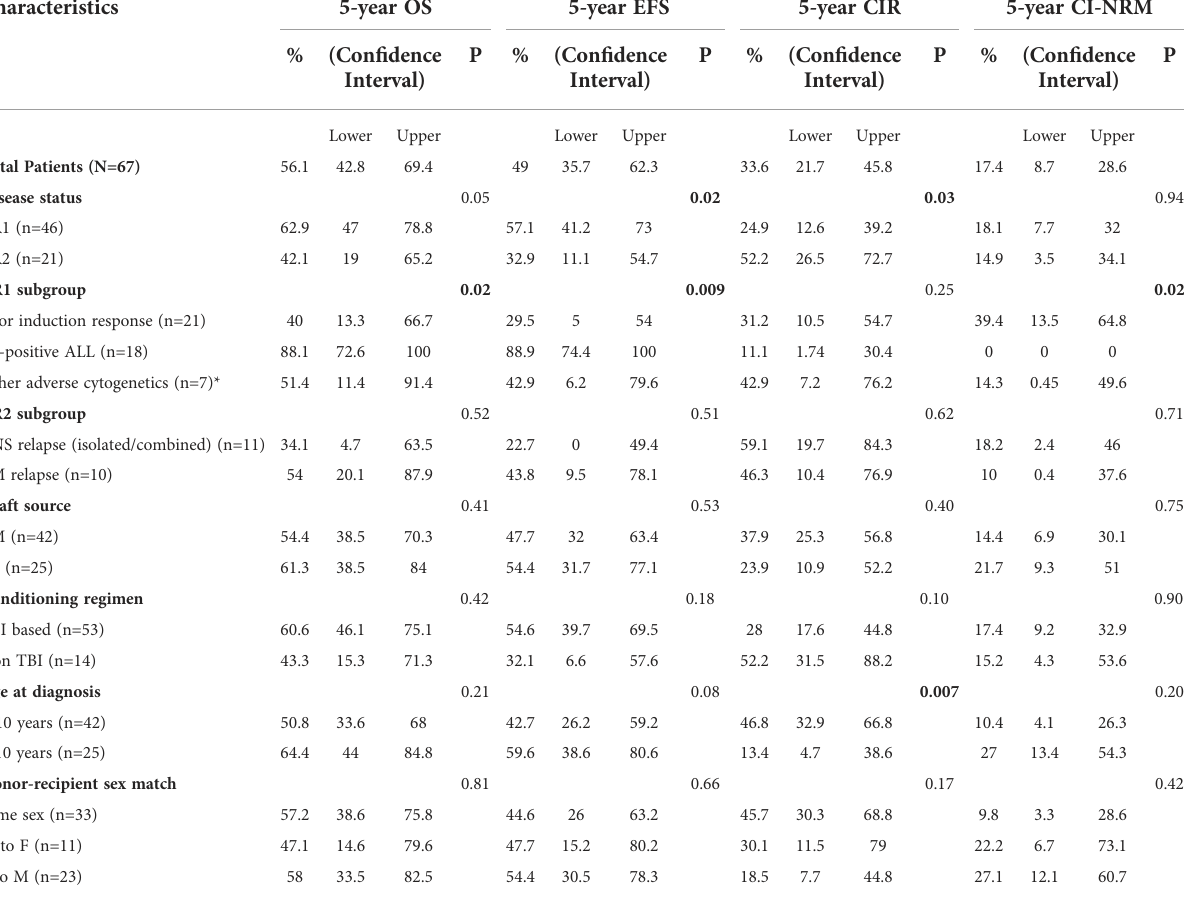
TABLE 4 Survival outcomes (OS and EFS), cumulative incidence of relapse (CIR) and cumulative incidence of non-relapse mortality (CI-NRM) post-HSCT in CR1 and CR2 transplants.